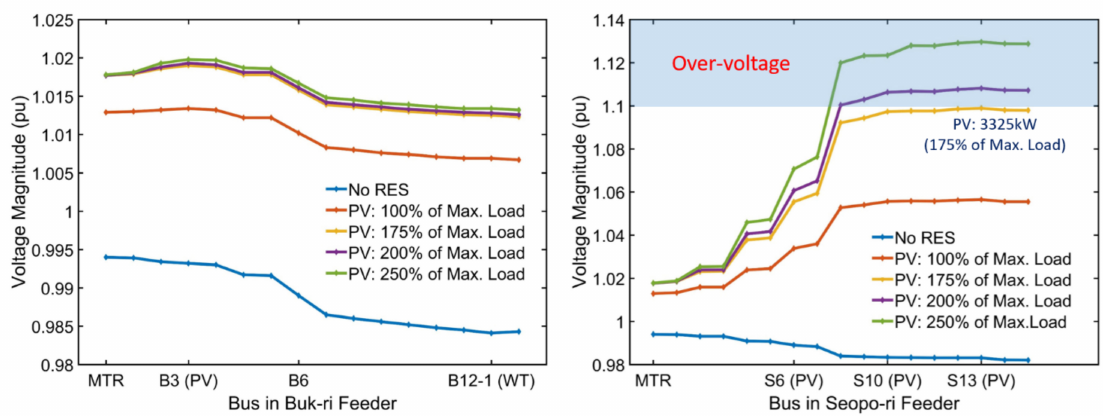
Figure 9. System voltage profile under minimum load and different PV generation